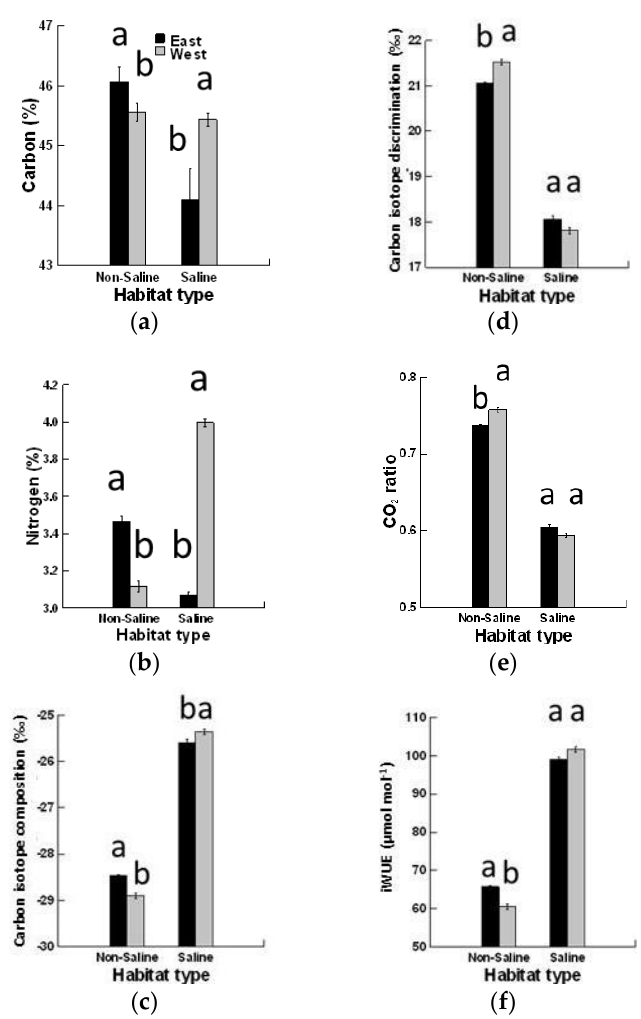
Figure 2. Effects of canopy position (east and west) and habitat (saline vs non-saline) on ( a ) carbon (%), ( b ) nitrogen (%), ( c ) carbon isotope composition (‰), ( d ) carbon isotope discrimination (‰), ( e ) C i/ C a ratio, and ( f ) intrinsic water-use efficiency of mature leaves of Prosopis pallida.